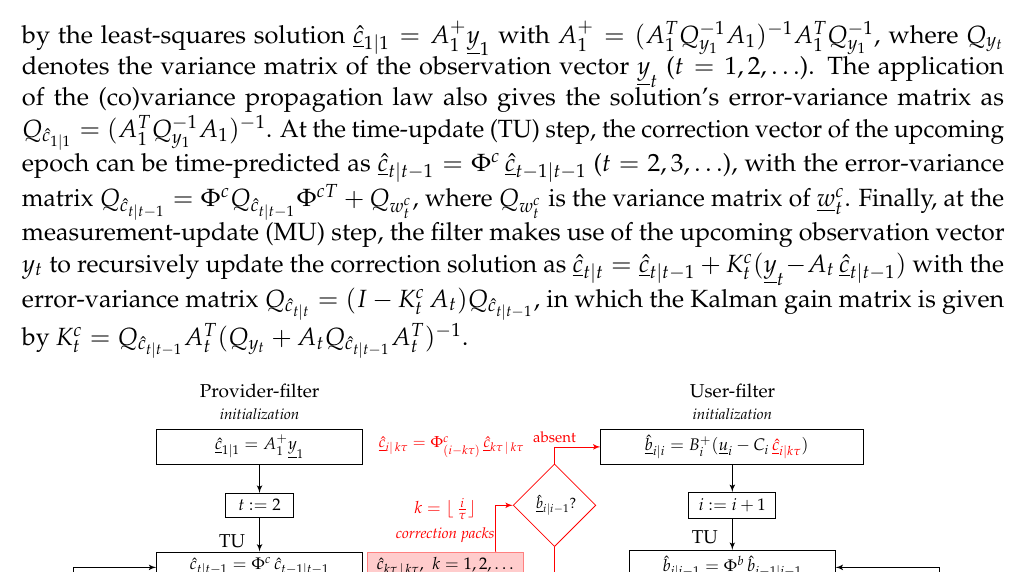
, where the operator returns the greatest integer i / τ x b c (cid:98) (cid:99) 1 is present, the user initializes their filter i | − C i ˆ c i − k τ . Otherwise, the correction pack is fed into the user | − |